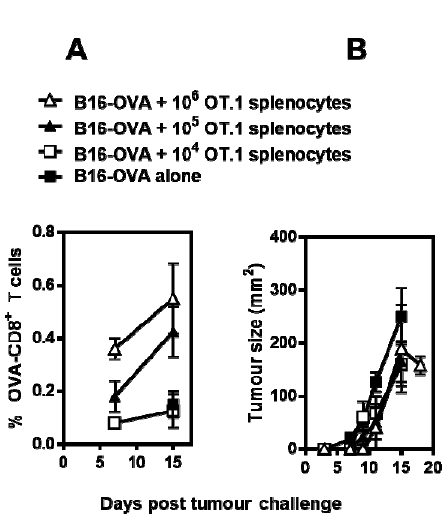
Figure A1. Basal level of circulating OVA-CD8 + T cells and the optimization of adoptively transferred OT.1 splenocytes for tracking OVA-CD8 + T cell responses. C57BL/6 mice were challenged s.c. with 10 6 B16-OVA. 3 days later PBS control, 10 4 , 10 5 or 10 6 OT.1 splenocytes are injected i.v. ( A ) Blood samples are taken to monitor OVA 257–264 specific CD8 + T cells; ( B ) Tumor size was monitored over time. (Mean ± SE, n = 5/group).